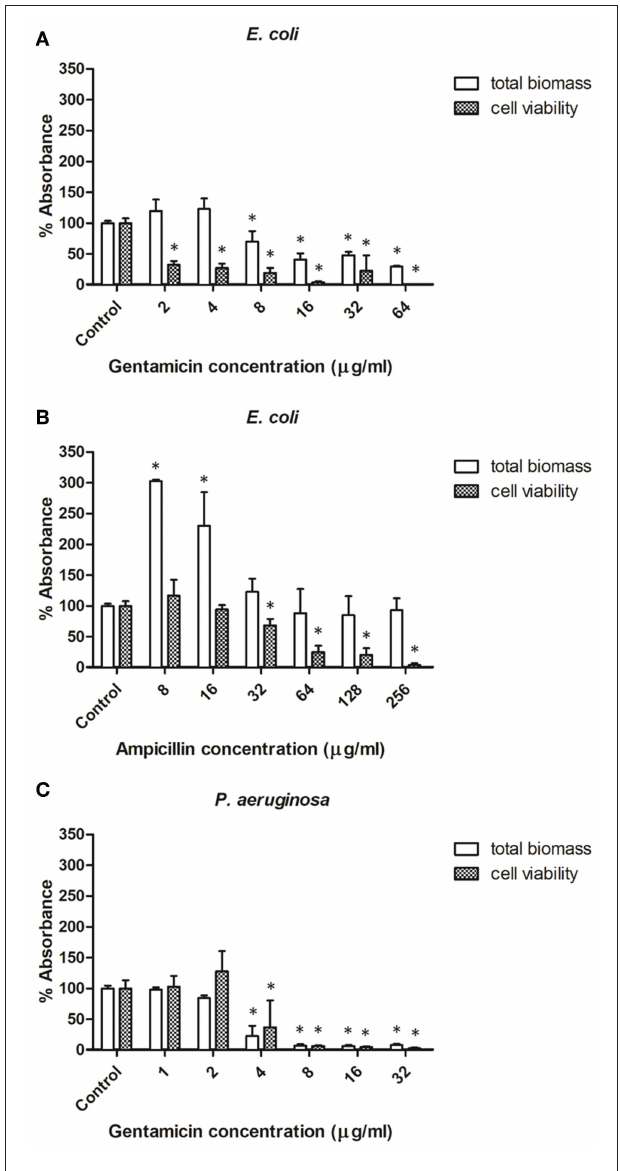
FIGURE 3 | Effect of antibiotic concentration on bacterial biofilm formation. (A,B) Biofilms formed by E. coli in presence of ampicillin and gentamicin, respectively. (C) Biofilms formed by Pseudomonas aeruginosa in presence of gentamicin. * indicates a significant difference between the corresponding untreated control and samples treated with antibiotics ( p <